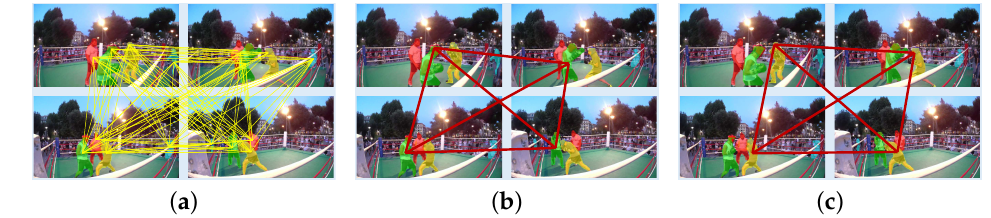
Figure 3. Illustration of finding salient object tracks over four frames in the “Boxing-fisheye” sequence: ( a ) complete 4-partite graph, ( b ) 1st salient object track Θ 1 , and ( c ) 2nd salient object track Θ 2